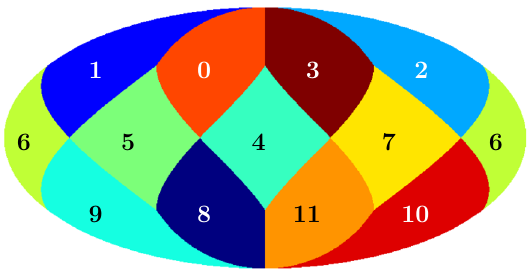
Fig. 5 The whole sky is divided into 12 equal-area regions by using HEALPix, which are labeled from 0 to 11. Note that here we use the same galactic coordinate system as in Fig. 1, rather than the default one of HEALPix. See the text for